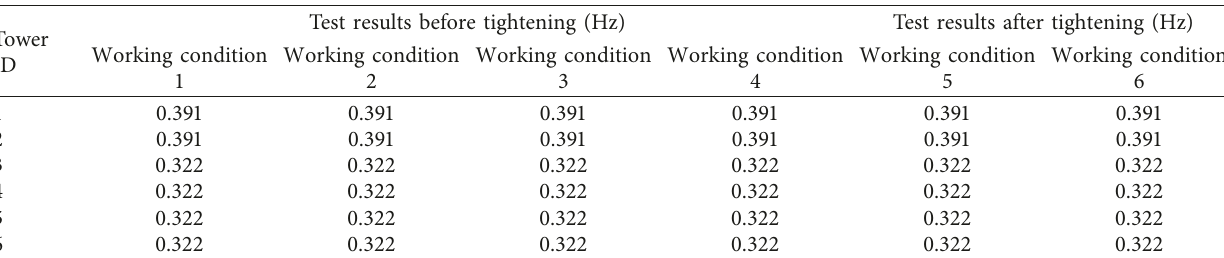
Figure 3: Vibration FFT spectra of two wind turbine towers (1 and 3). The spike in each subplot corresponds to the first-order natural frequency of each tower. (a) Vibration FFT spectra of No. 1 wind turbine tower. (b) Vibration FFT spectra of No. 3 wind turbine Table 4: Natural frequencies of the wind turbine towers.